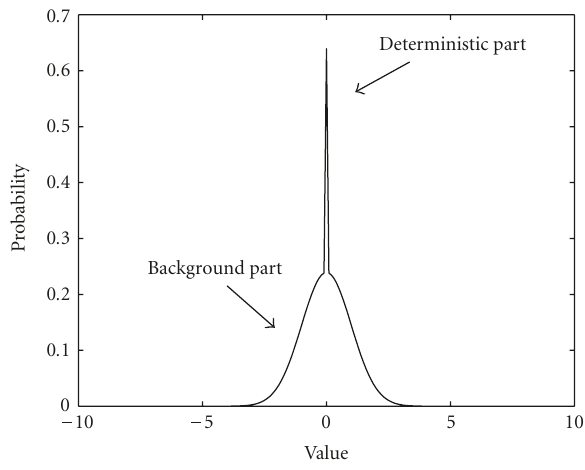
Figure 5: Example of probability density function on a computa- tion window for a low SNR ( p = 0 .